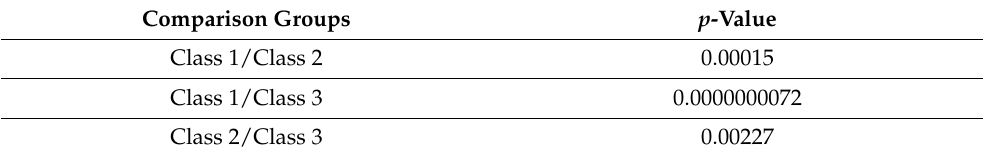
Table 5. The p -value result of pairwise comparisons of classes by provenance (for α = 0.05). Comparison Groups p -Value